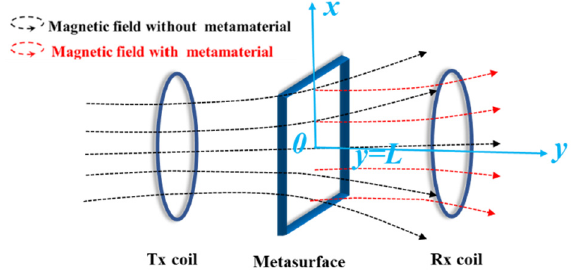
Figure 1. The WPT system for loading the negative permeability metasurface.